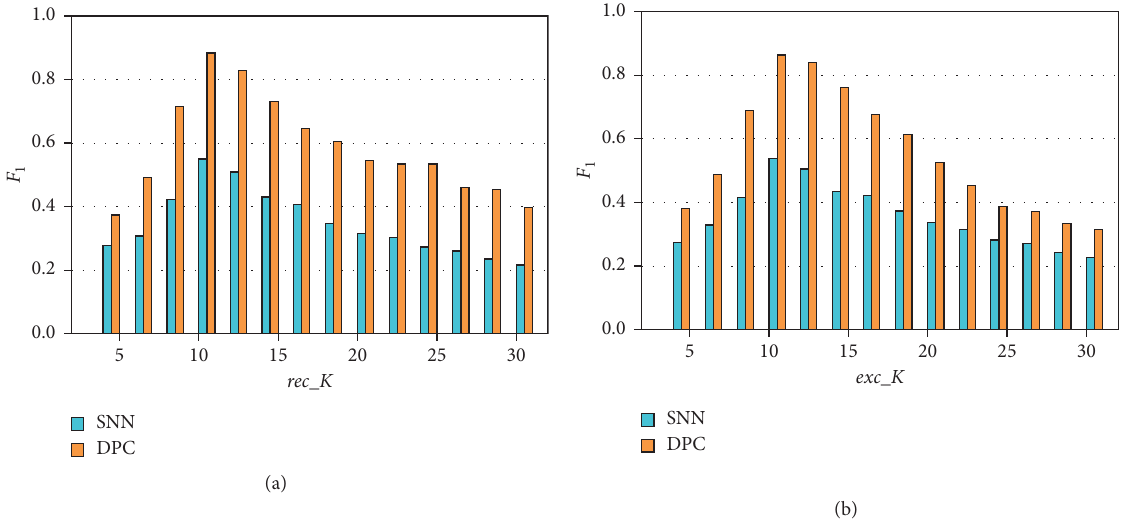
Figure 7: Efficiency comparison of different clustering methods on the dataset